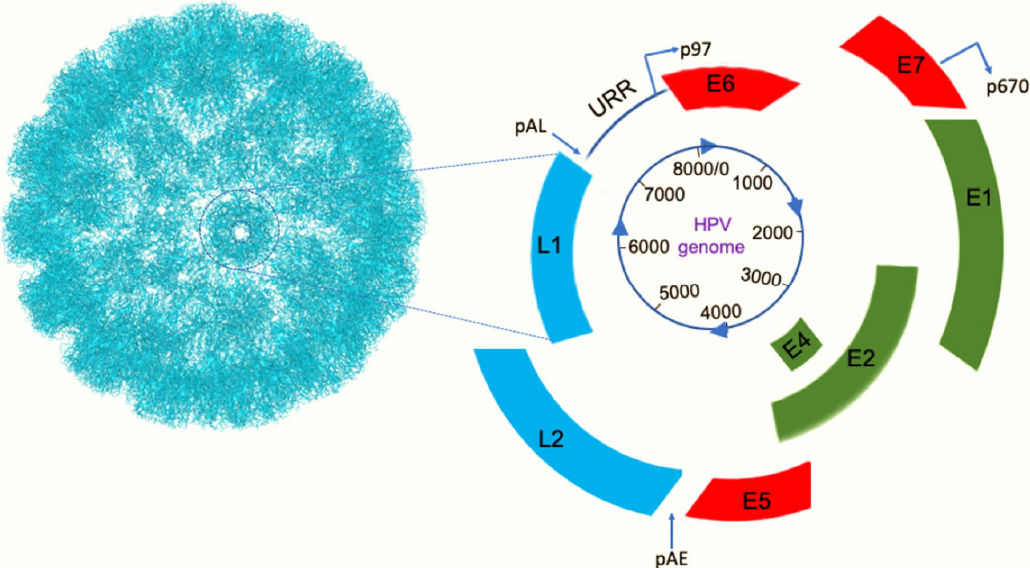
Figure 1 . A schematic of the genome of HPV16 and capsid proteins. Right image: genes that code for early proteins (E1, E2, E4, E5, E6, and E7), are shown in red and green colors; E5, E6, and E7 are oncogenes. Genes that code for late proteins (L1 and L2; capsid proteins) are shown in light blue color. URR (upstream regulatory region) contains origin of replication, enhancer elements, and early promoter (p97); URR controls viral replication. p670 is the late promoter. pAE and pAL are early polyadenylation and late polyadenylation sites, respectively. Left image: The L1 protein forms pentamers (one is circled) and each pentamer has an L2 protein at its center (not shown). Seventy-two copies of the pentamers assemble to form an icosahedral capsid.